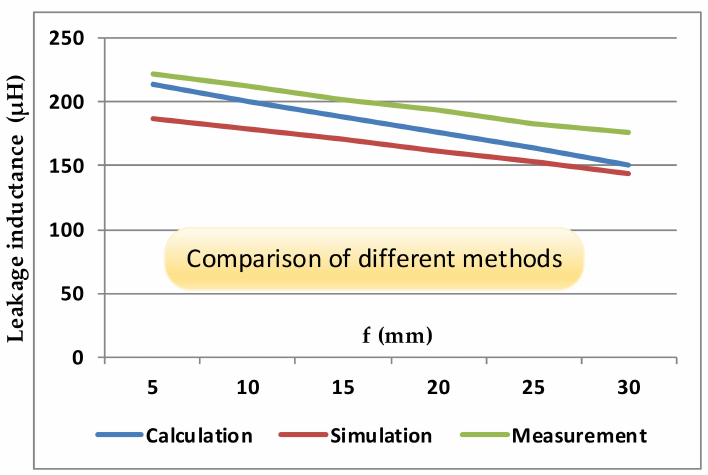
Figure 8. Comparison of leakage inductance value with different methods under parameter f